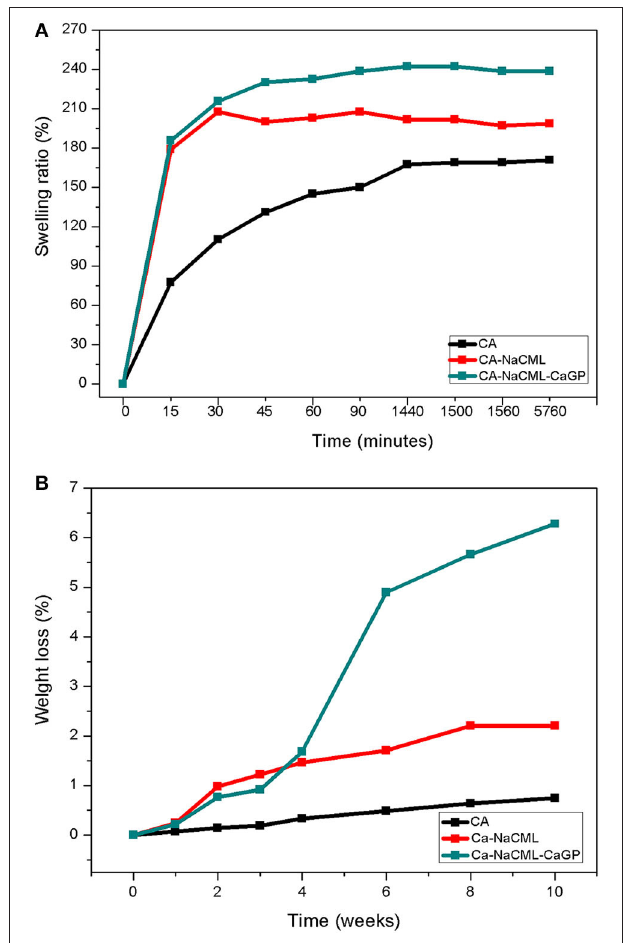
FIGURE 6 | (A) Swelling of the membranes over a period of 96h and (B) Degradation profile in percent of weight loss of the